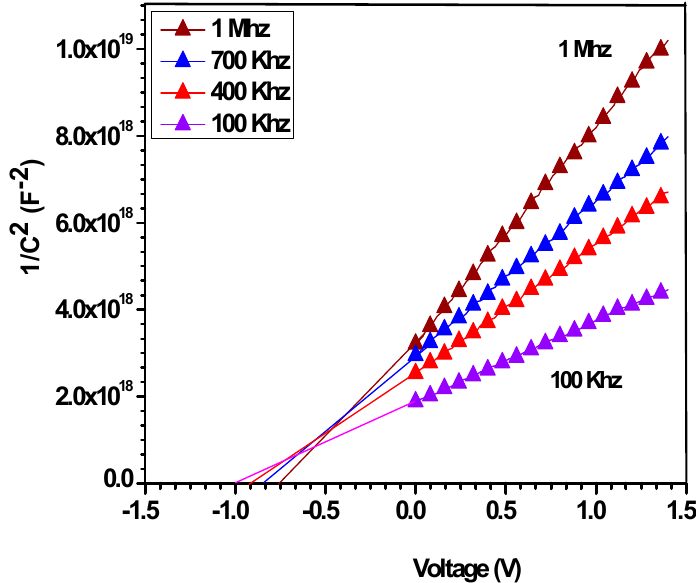
Figure 7. Plot of the 1/ C − 2 – V for the as-deposited Al/SiO 2 / p -GaN MOS Schottky diode measurement at different frequencies between 100 kHz and 1 MHz, AC = 100 mV.